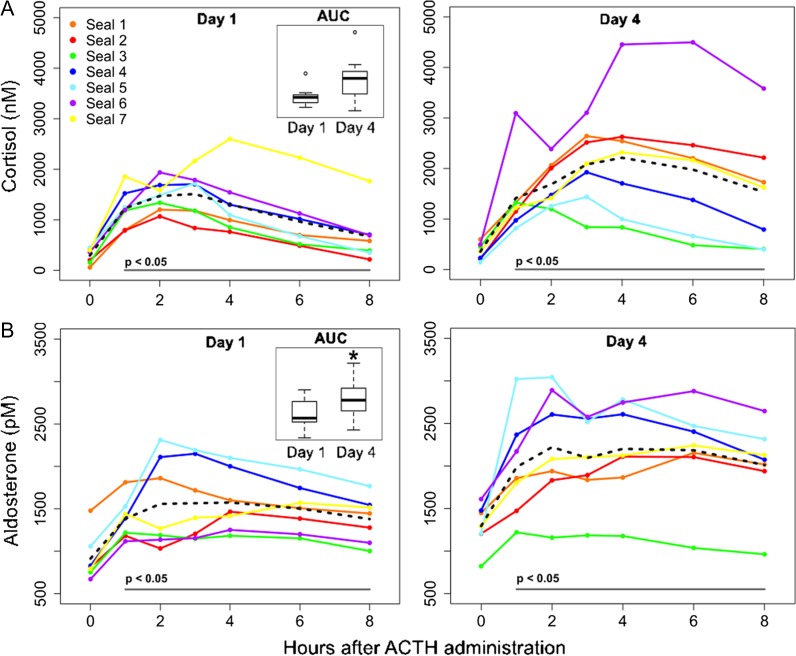
(A) Cortisol concentrations (1–8 h) increased relative to pre-ACTH (0-h) levels following ACTH administration on Days 1 (left panel) and 4 (right panel; LMM: F6, 36 = 20.7 and 10.1 for Days 1 and 4, respectively, P < 0.0001). Total cortisol response (area under the curve, AUC, inset plot) and peak cortisol levels did not differ between Days 1 and 4 (paired t-test, AUC: P = 0.12, peak: P = 0.13). (B) Aldosterone increased relative to pre-ACTH (0-h) concentrations following ACTH administration on Days 1 (left panel) and 4 (right panel; LMM: F6, 36 = 9.76 and 13.6 for Days 1 and 4, respectively, P < 0.0001). Aldosterone concentrations were significantly elevated on Day 4 relative to Day 1 (AUC, inset plot; paired t-test, P < 0.05). The dashed lines show mean hormone levels. *Denotes statistically significant difference in AUC concentrations between days. The grey bar at the bottom of each panel denotes significant differences in post-ACTH hormone concentrations relative to 0-h levels on each day.